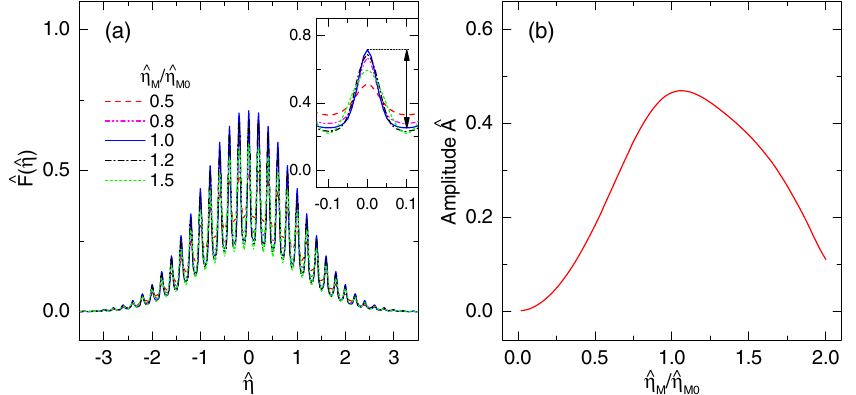
ˆ F computed with ˆ η M 0 ¼ 0 . 1 and ˆ σ x ¼ 0 . 02 : (a) ˆ A ˆ F ˆ F ¼ ð 0 Þ − ð ˆ η M 0 Þ plotted as a function of ˆ η M = ˆ η M 0 . The arrow indicated in the inset of (a) shows